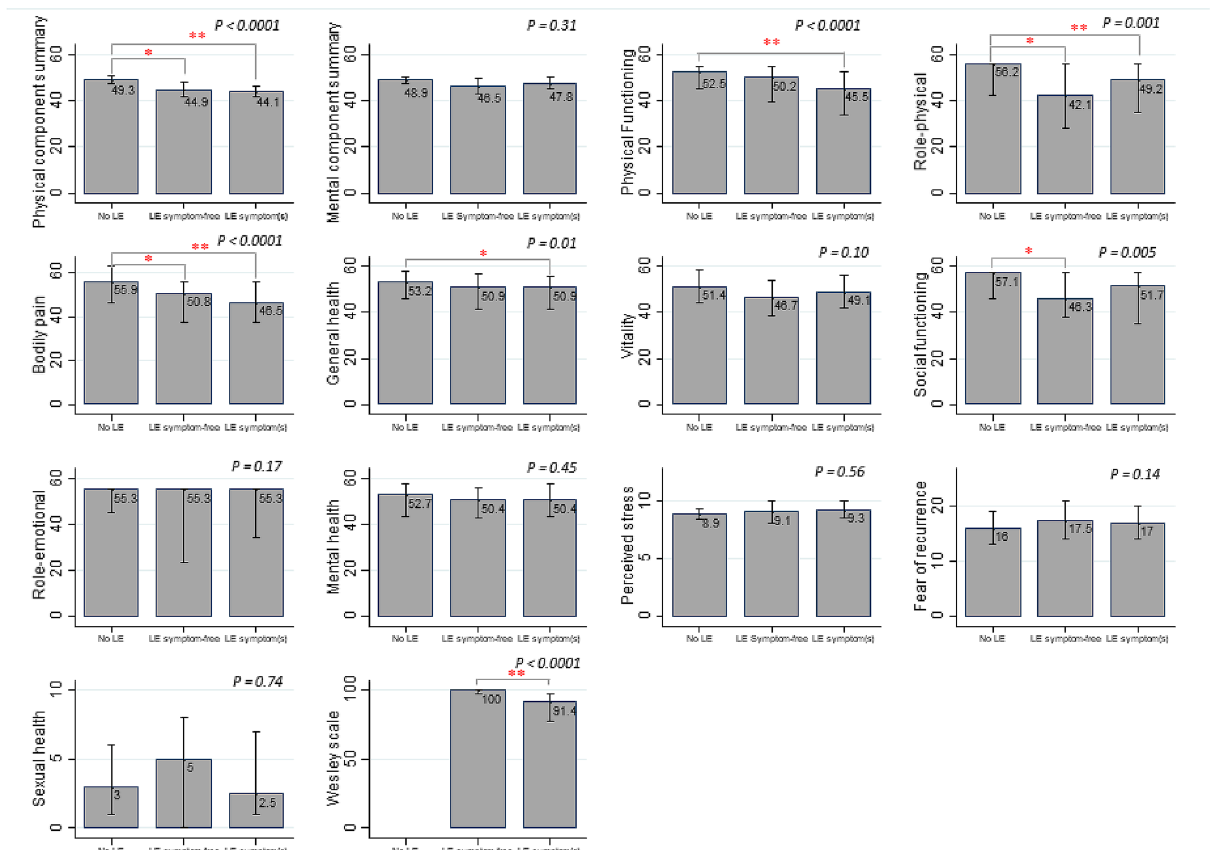
Figure 2. Lymphedema and health-related quality of life measures. Adjusted means are presented for the SF-36 physical and mental component summary scores and perceived stress scale. Medians are presented for the other health-related quality of life measures. The vertical lines represent the 95% confidence intervals for the means and the interquartile ranges for the medians. A higher score indicates better health-related quality of life in Medical outcomes study 36-item short form health survey scales and Wesley Clinical Lymphedema Scale and worse health-related quality of life in perceived sterss, fear of recurrence, and sexual health scales. P values are based on F statistics from the analysis of covariance in 499 women (for the analysis of sexual health, only 288 women who reported being sexually active during the 6 months prior to 40-month assessment were included). Asterisk(s) indicate a statistically significant difference observed in Scheffé’s pair-wise multiple comparison test (*0.01 ≤ P value < 0.05, ** P value < 0.01). LE